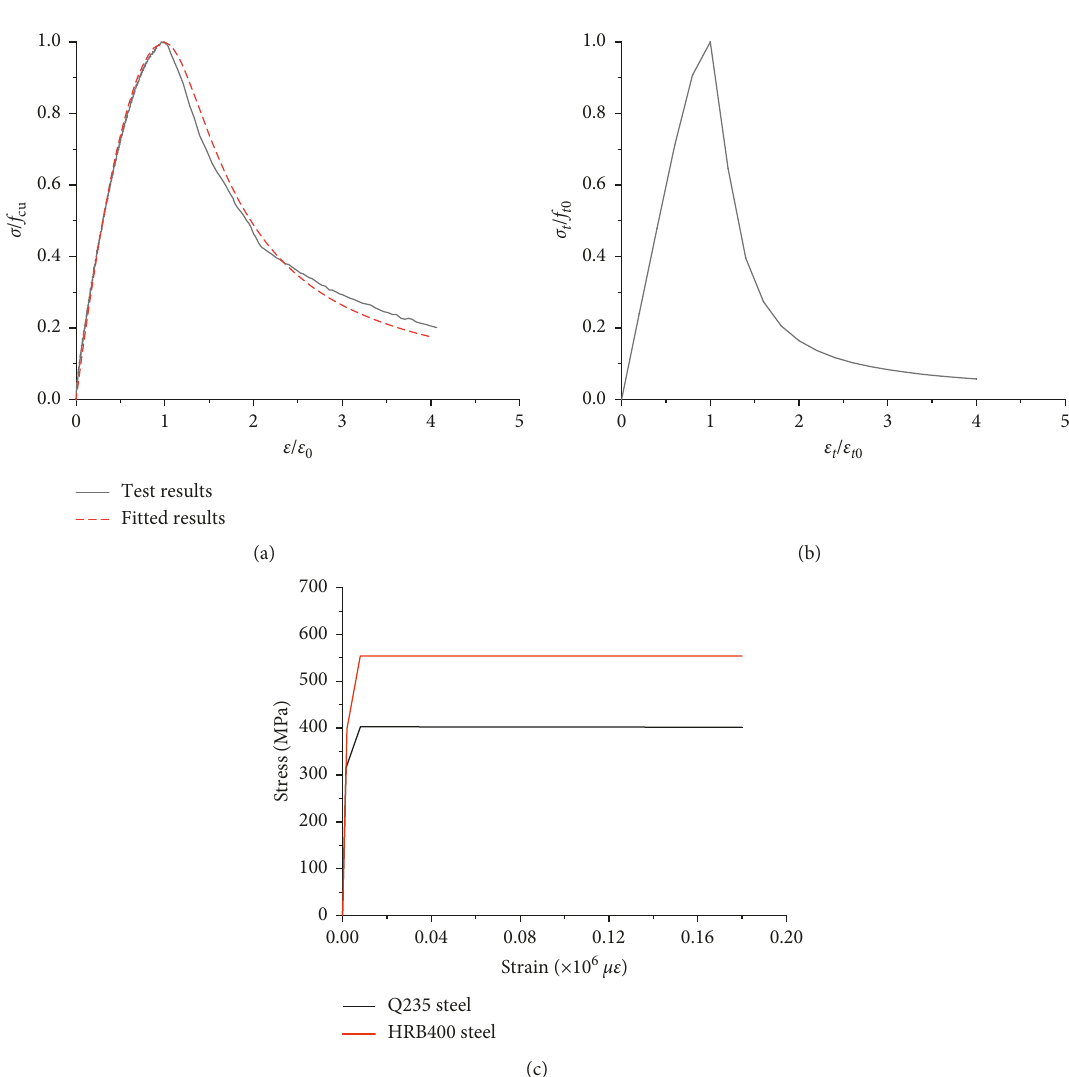
Figure 9: Stress-strain relationship for the materials: (a) regression of nondimensional measured compressive stress-strain relationship of RAC; (b) normalized tensile stress-strain relationship for RAC; (c) stress-strain relationship for steel